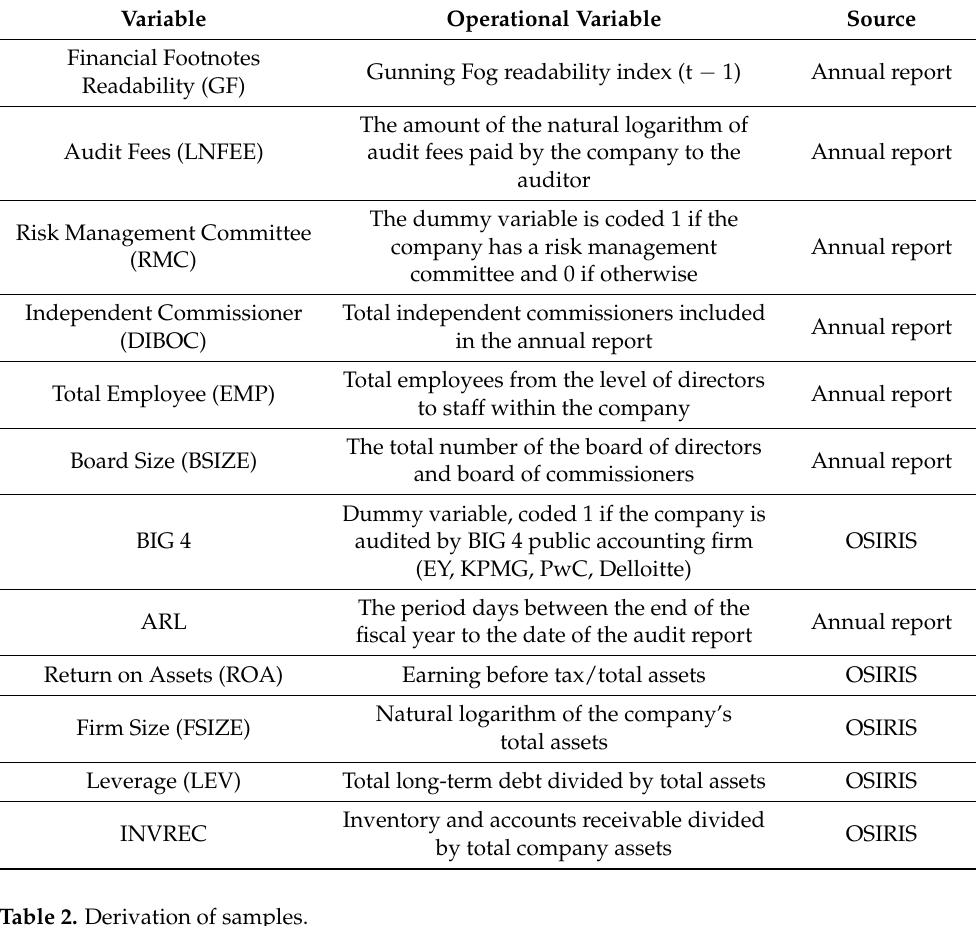
Table 1. Variable definition.